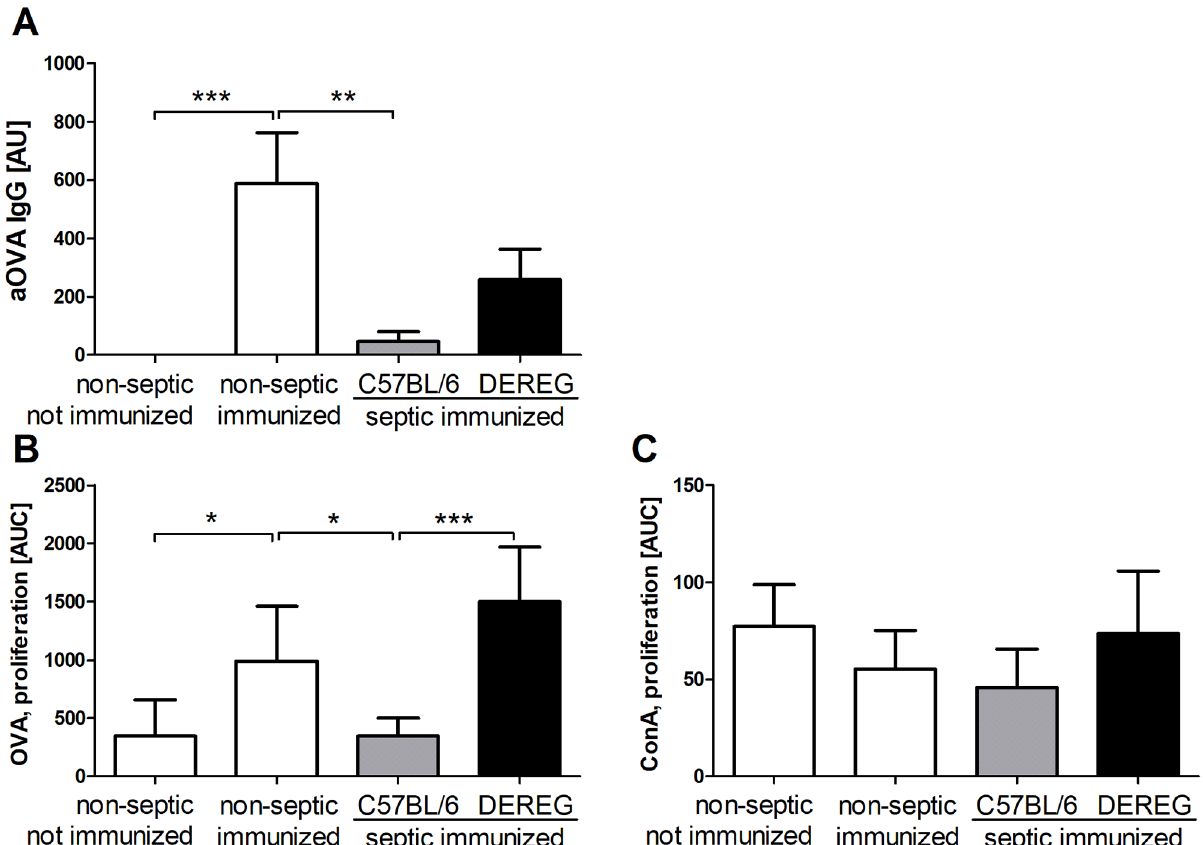
Fig 2. Treg depletion prior to immunization of post-septic animals. In DEREG mice (n = 15) and C57BL/6 wild-type controls (n = 9) sepsis was induced, and on days 5 and 6 the animals were given 1 μ g of diphtheria toxin intraperitoneally to deplete Tregs. On day 7, the animals were immunized intraperitoneally with TNP-OVA/OVA in alum. Non-septic, not immunized animals (n = 11) and non-septic immunized animals (n = 10) served as controls. (A) 14 days after immunization, the antigen-specific immune response was determined by the concentration of anti-OVA IgG in the serum via ELISA and normalized to a standard serum (arbitrary units, AU). (B) The proliferative response of splenocytes to restimulation with OVA was measured by thymidine incorporation ex vivo . (C) The proliferative response to the mitogen concanavalin A (ConA) served as control. Means and 95% confidence intervals are shown. Group differences were tested for significance with the Kruskal-Wallis test and Dunn’s multiple comparison for selected pairs. Pooled results from three separate experiments with the same tendency are shown. (cid:3)(cid:3)(cid:3) P < 0.001; (cid:3)(cid:3) P < 0.01; (cid:3) P < 0.05.